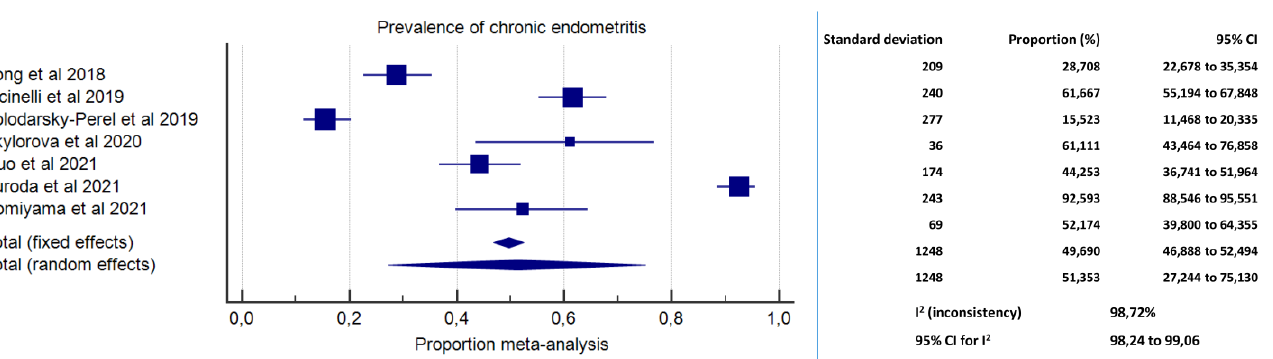
Figure 2. Forest plot. Prevalence of chronic endometritis in pre-menopausal women with endometrial polyps.